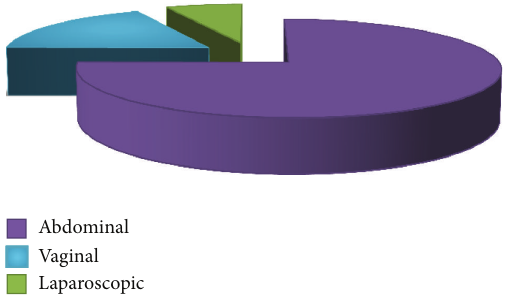
Figure 1: Proportion of various approaches of hysterectomy.